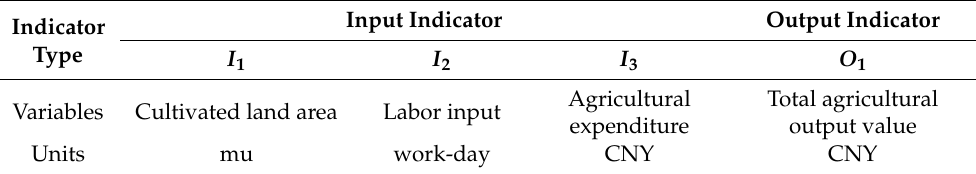
Table 2. Input–output indicators for rural households’ CLUE